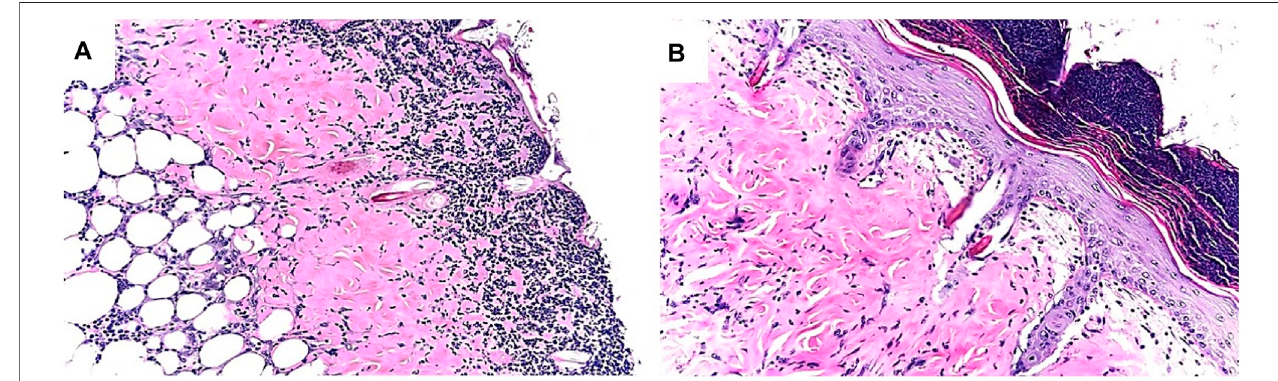
FIGURE 9 | Example of differences in healing of skin burns in anti-Gal – producing GT-KO mice treated with saline (A) or with α -gal nanoparticles (B) , 6 days post injury. Note the accumulation of macrophages and neutrophils under the surface of the exposed injured dermis in the saline-treated injury, whereas in the α -gal nanoparticles – treated injury, the epidermis is fully regenerated, including the stratum corneum. The recruited macrophages and neutrophils are observed on the top of the intactepidermis.Adapted from GaliliU. The naturalanti-Gal antibodyasfoe turnedfriend inmedicine .PublishersAcademic Press/Elsevier,London,2018,with